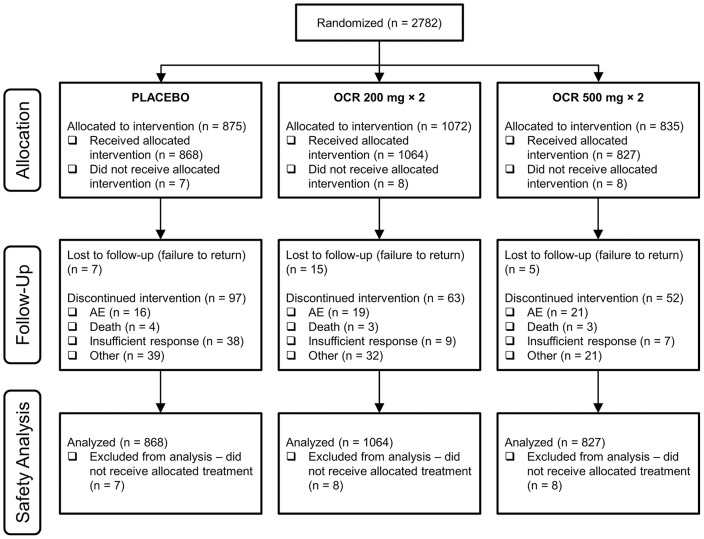
Patient disposition flow diagram of pooled safety population.